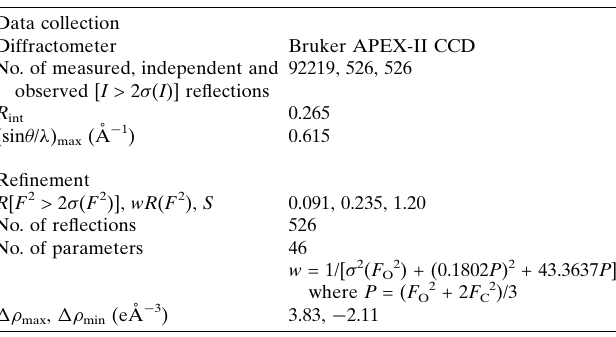
Table 3 Experimental details for the PtPOP data measured at SACLA. Note that crystalline water molecules and hydrogens have been